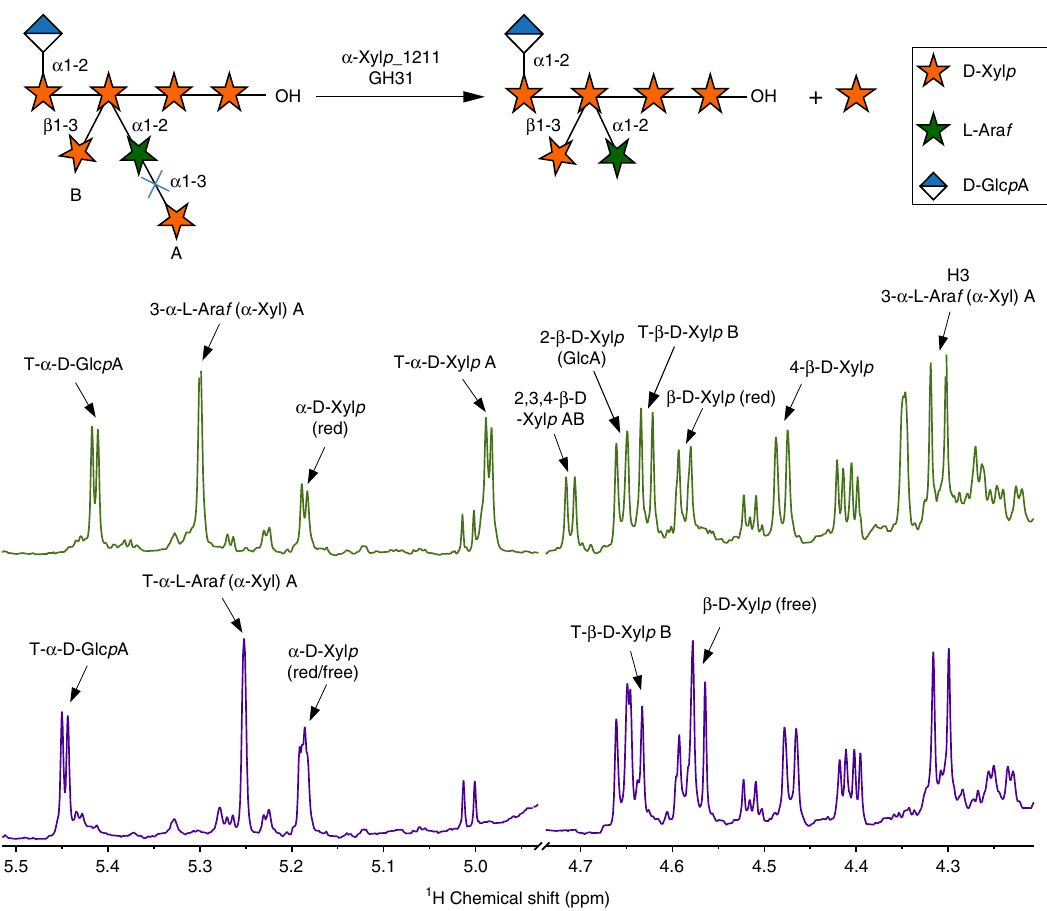
Fig. 3 Activity of the α -xylosidase α - Xylp _1211 against the Coculture Broth acidic oligosaccharide. The GAX acidic oligosaccharide was isolated from the TS -Coculture Broth and incubated with the α -xylosidase α -Xyl p _1211 for 2 h. The oligosaccharide was analyzed by NMR before and after the incubation with the enzyme. The oligosaccharide contains a disaccharide α - D -Xyl p (1,3)- α - L -Ara f -(1,2)- (A) and a T- β - D -Xyl p -(1,3)-residue (B) that are attached to the double substituted 4-linked β - D -Xyl p in the backbone (AB). The disappearance of signal for terminal (T) α - D -Xyl p in the 1D 1 H NMR spectrum of the oligosaccharide after the incubation, indicates that the enzyme effectively removed this residue from A. A diagram of the acidic oligosaccharide structure and the enzymatic reaction is included at the top of the fi gure.